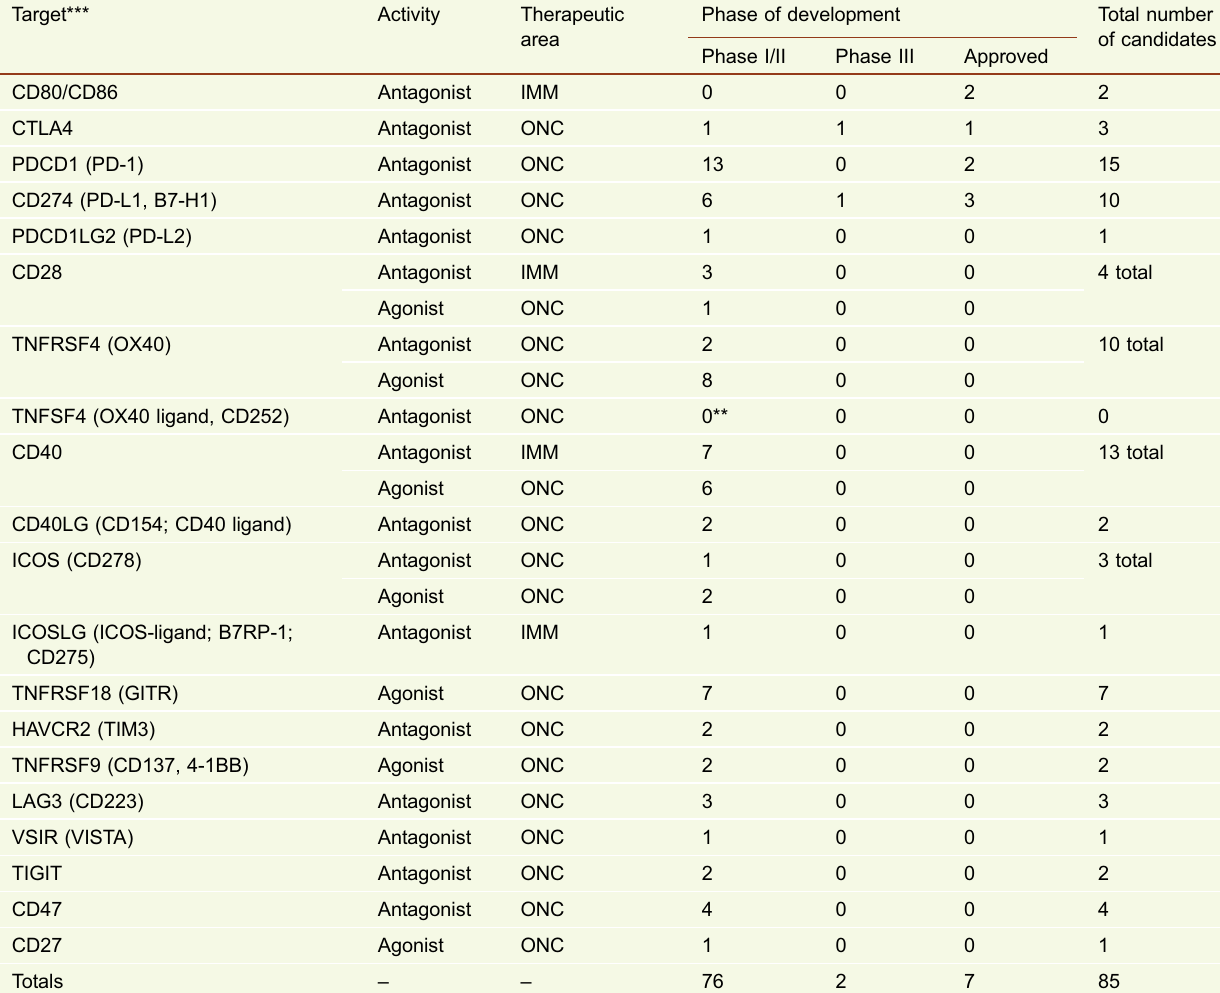
Table 10. mAbs and Fc fusion proteins directed towards immunomodulation and checkpoint targets*